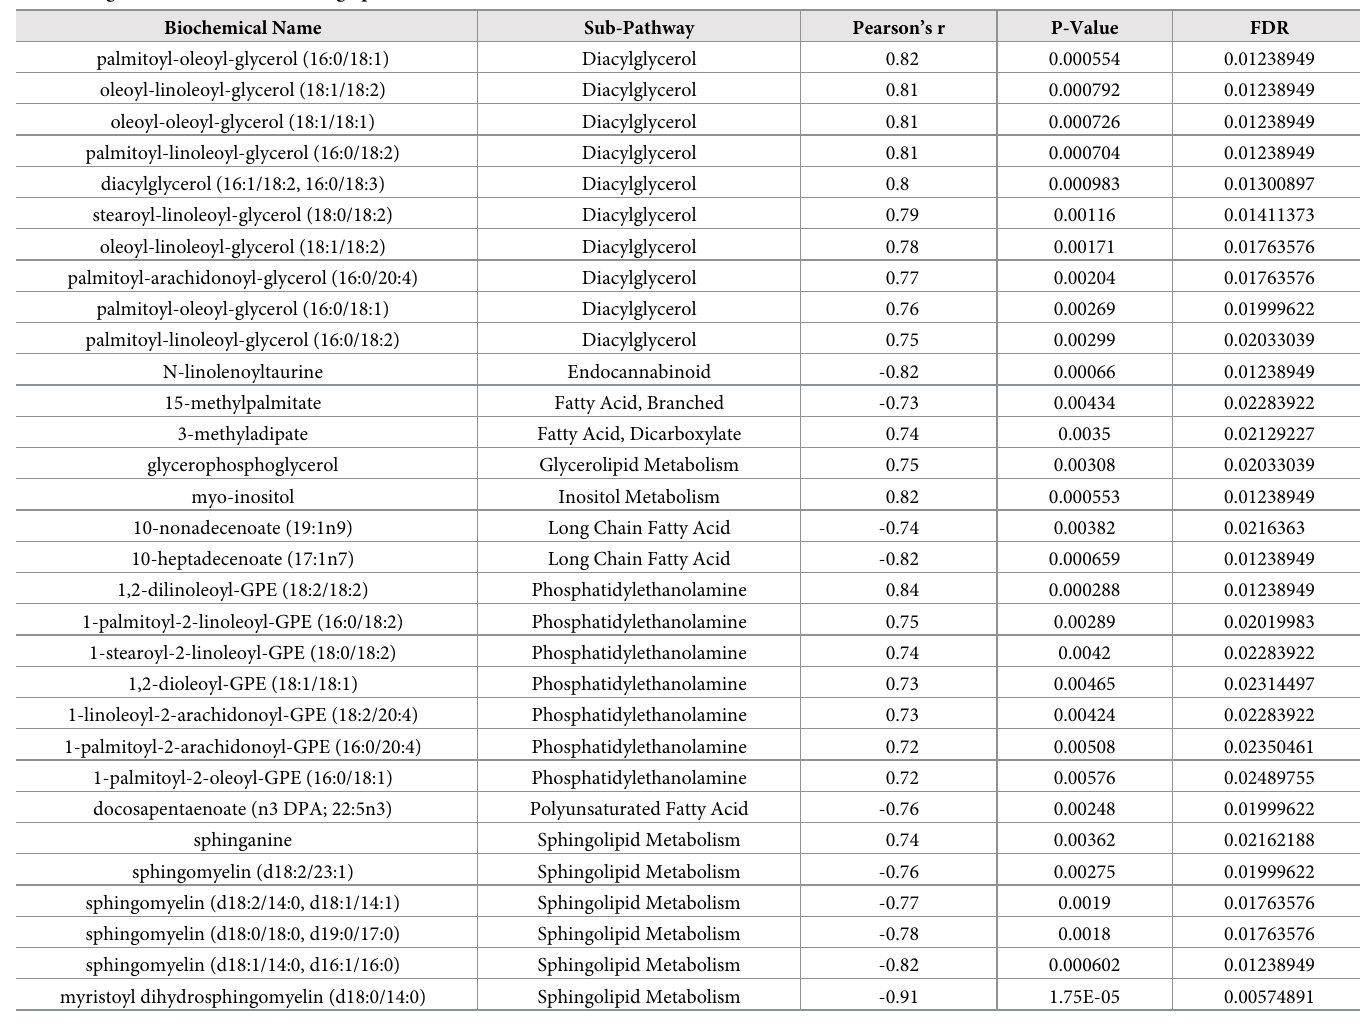
Table 2. Significant correlations among lipid metabolites and serum